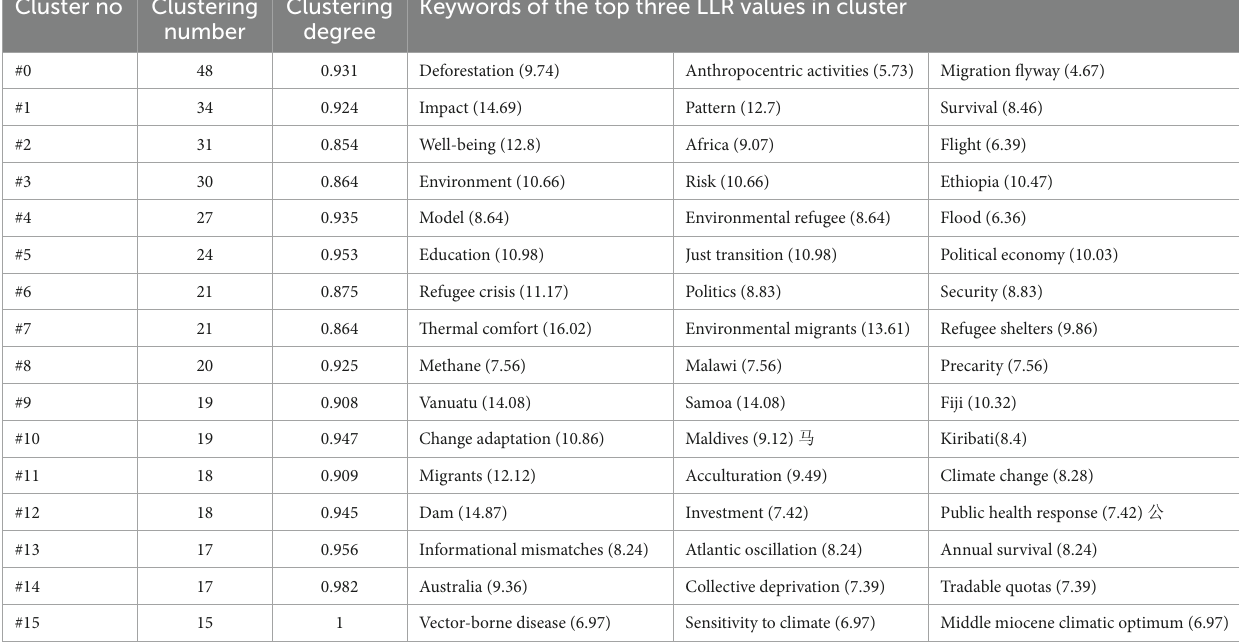
TABLE 6 Keyword clustering table (WOS 2008–2021). Keywords of the top three LLR values in cluster